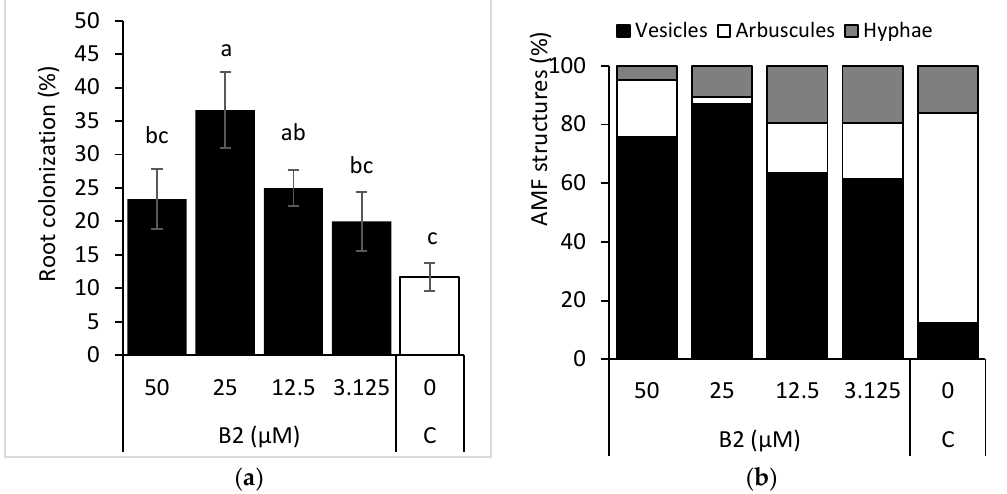
Figure 2. Riboflavin stimulates arbuscular mycorrhizal fungi (AMF) colonization. ( a ) Root coloni- zation percentage by AMF, and ( b ) proportion of AMF structures in roots with different riboflavin concentrations 35 days after inoculation. n = 4. Bars represent the mean ± standard deviation. Different letters indicate significant differences between treatments, Tukey HSD ( p ≤